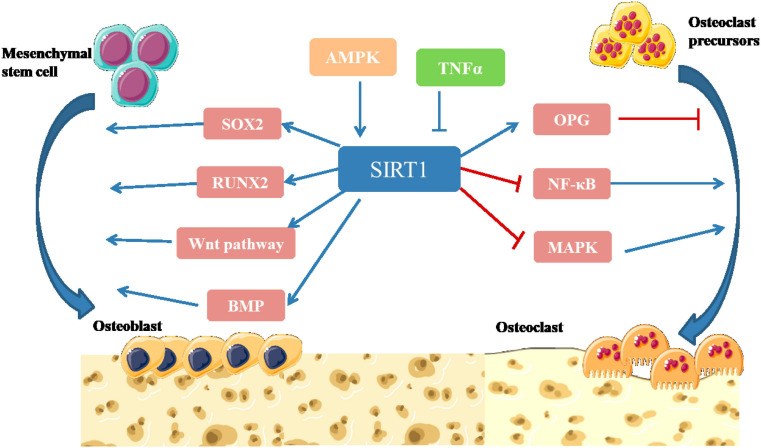
Illustration of SIRT1 signaling pathway in bone remodeling (Cohen-Kfir et al., 2011; Shakibaei et al., 2011; Edwards et al., 2013; Feng et al., 2014; Iyer et al., 2014; Kim et al., 2015; Liu J. et al., 2016). SIRT1 participates in intracellular energy metabolism through AMPK signaling pathway, and regulates bone metabolism in an AMPK-dependent manner. SIRT1 can promote the differentiation of MSCs into osteoblasts by directly deacetylating SOX2. SIRT1 can deacetylate β-catenin and promote β-catenin to accumulate in the nucleus, thus further activating Wnt pathway to promote Osteogenesis differentiation. SIRT1 can activate the transcription factor RUNX2 and promote the differentiation of MSCs into osteoblasts. Activation of SIRT1 can significantly increase the expression level of BMP-2 and BMP-7 to promote bone repair. SIRT1 inhibits NF-κB degradation, downregulates NF-κB signaling and inhibits bone resorption. Activation of SIRT1 can significantly inhibit the activity of MAPK signaling pathway by inhibiting the expression of prostaglandin, promote the expression of OPG and inhibit osteoclast generation and bone resorption (Yang and Tang, 2019).